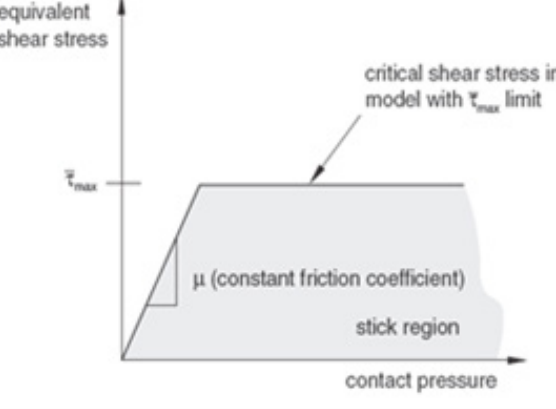
Figure 10: The CAX4R element (Abaqus V6.12-1).